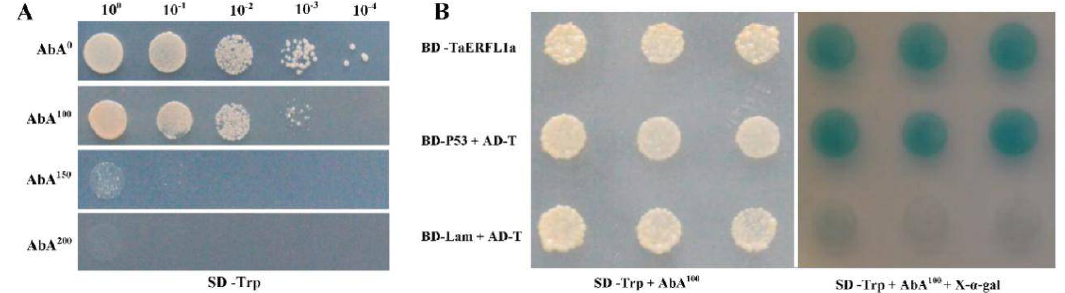
Figure 5. Growth of yeast strain Y2HGold containing pGBKT7-TaERFL1a on the selective media with different concentrations of AbA ( A ); and transcription activation of TaERFL1a ( B ). Concentrations of AbA are used at 0, 100, 150, and 200 ng/mL in Y2H assay. Transformed yeast cells harboring TaERFL1a grow on SD/-Trp + AbA 100 , or SD/-Trp + AbA 100 + X- α -gal media. BD-P53 + AD-T (pGBKT7-P53 + pGADT7-RecT) and BD-Lam + AD-T (pGBKT7-Lam + pGADT7-RecT) act as the positive and negative controls, respectively.